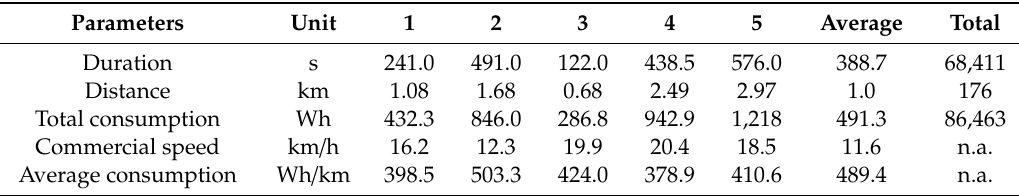
Table 1. Road testing results of P1.